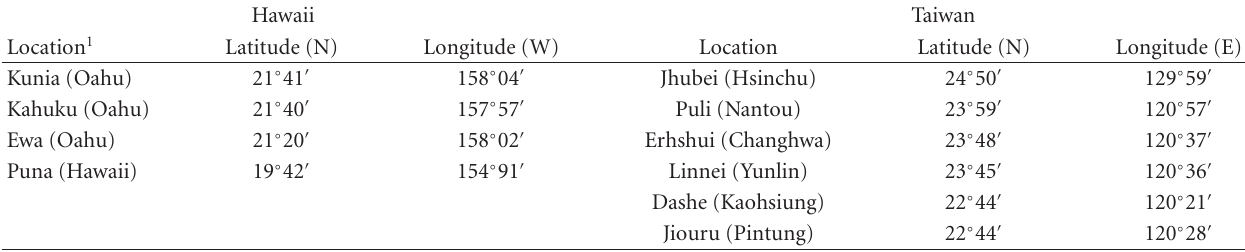
Table 1: Collections by location and global positioning data of wild Bactrocera cucurbitae populations tested for insecticide susceptibility in Hawaii and